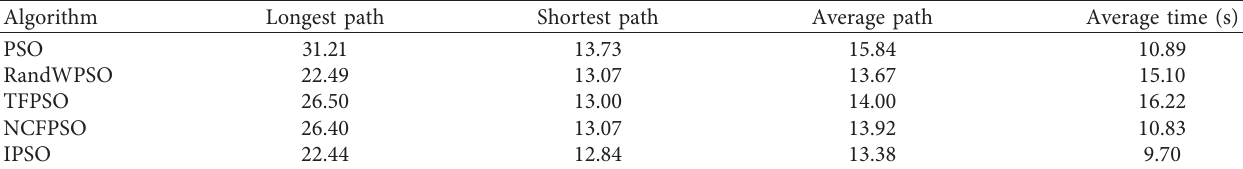
Table 4: The first comparison of path length of five algorithms in the complex environment. Algorithm